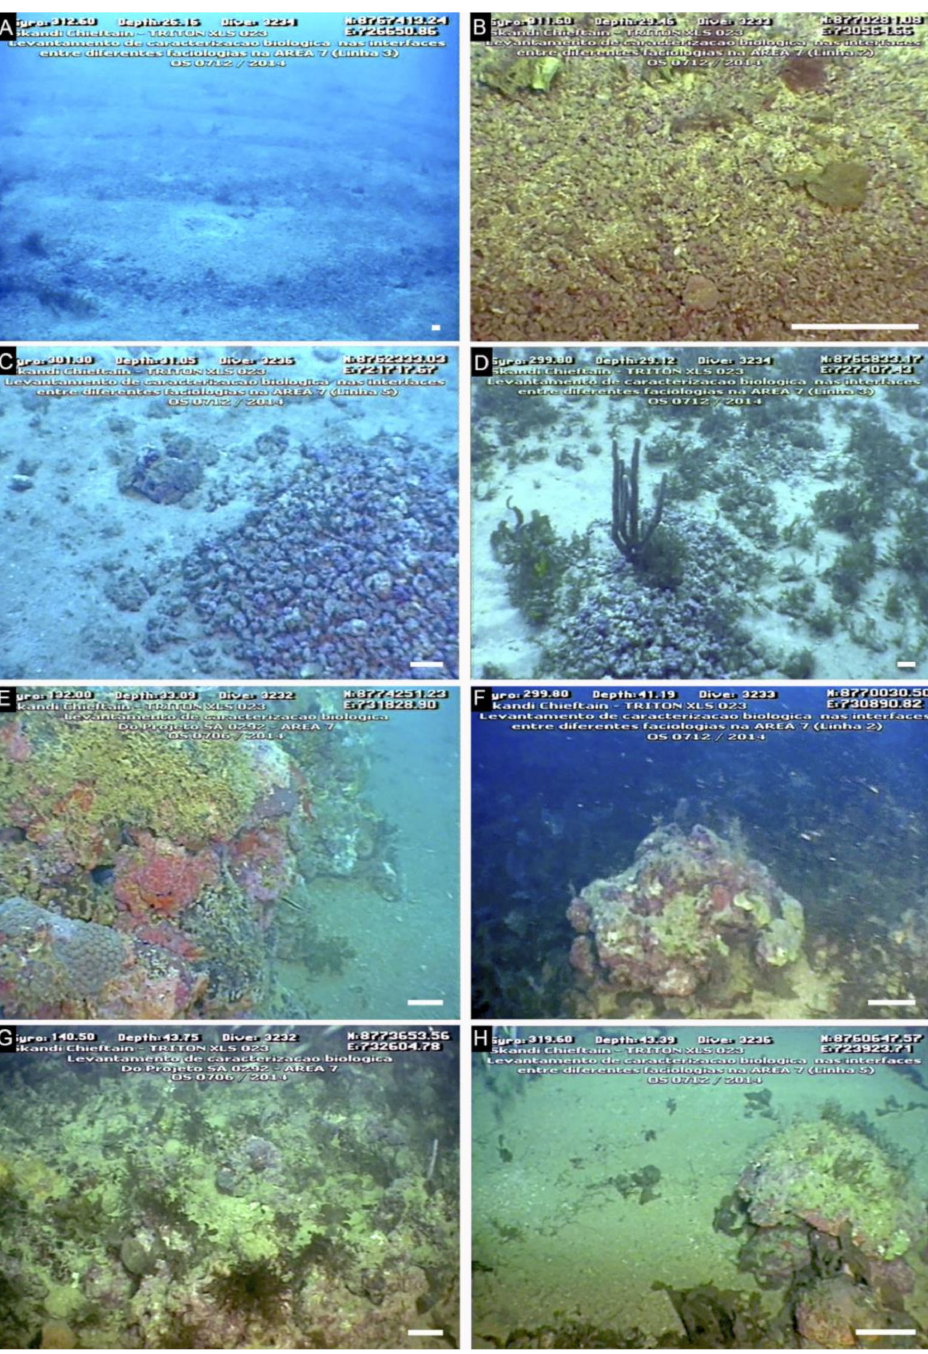
Figure 2. In situ images of the explored sites on the middle and outer shelf of the south sector of the SEAL Basin: ( A ) Zoom-out of fruticose rhodoliths on ripple troughs (darker colours) at 30 m depth; ( B ) Zoom-in of the seafloor dominated by living fruticose rhodoliths at 30 m depth (vinaceous colours); ( C , D ) Rhodolith patches at 30 m depth, depicting the sponge Aplysina sp.; ( E ) Reef formed by fused rhodoliths associated to corals ( Montastraea cavernosa ), macroalgae and encrusting sponges ( Monanchora arbuscula ) at 32 m depth; ( F , G ) Coalescent rhodoliths forming complex three-dimensional structures covered by macroalgae, at 41 and 43 m depths, respectively; ( H ) Rhodoliths partially buried by fine-grained sediment with living coralline algae covered by green macroalgae at 43 m depth. Scale bars = ~5